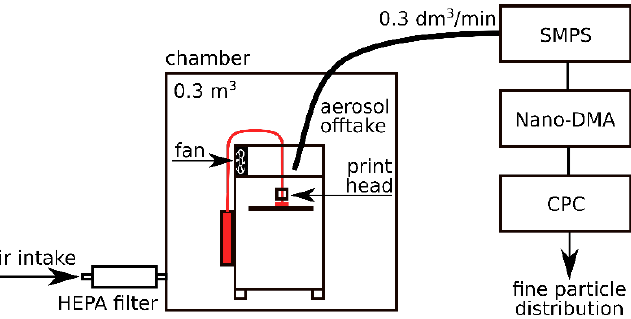
Figure 1. Diagram of the experimental setup.